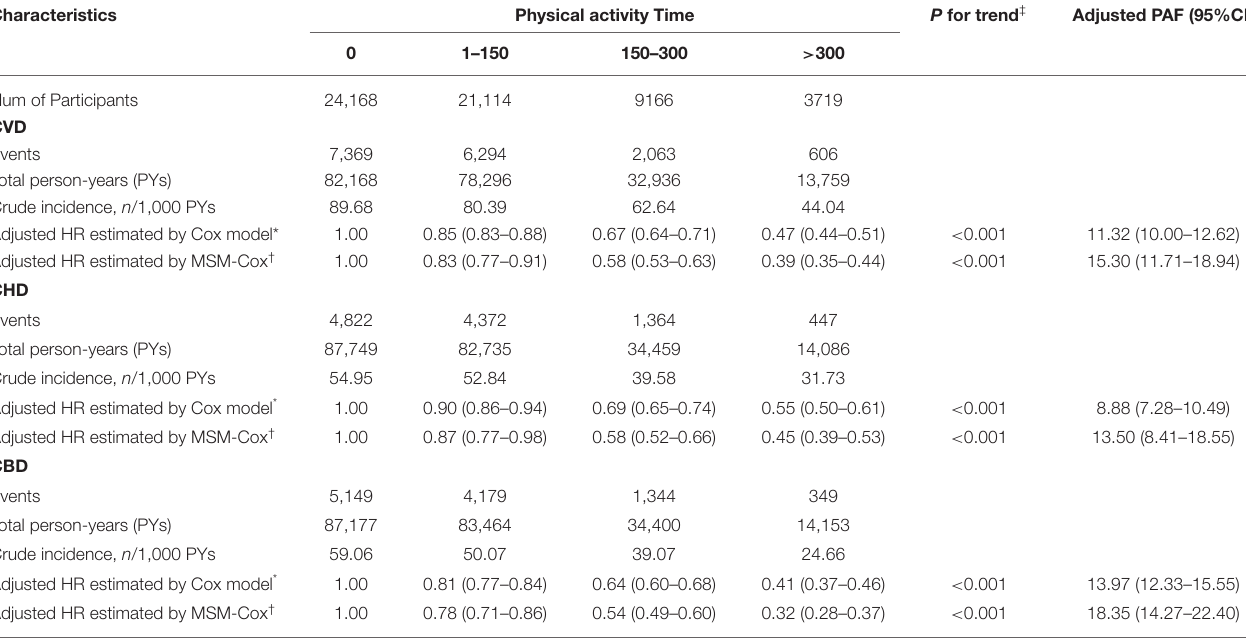
TABLE 2 | Adjusted hazards ratios for risk of CVD, CHD, CBD, and PAF associated with PAT. Characteristics